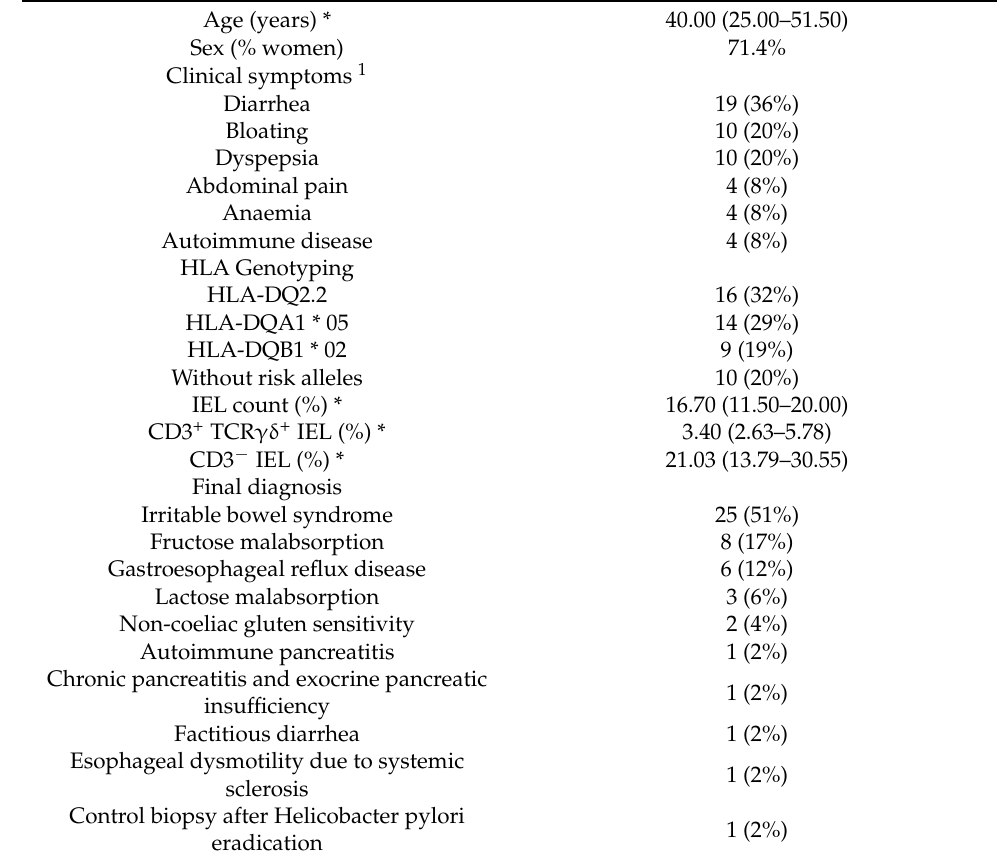
Table 3. Clinical characteristics of the control group.